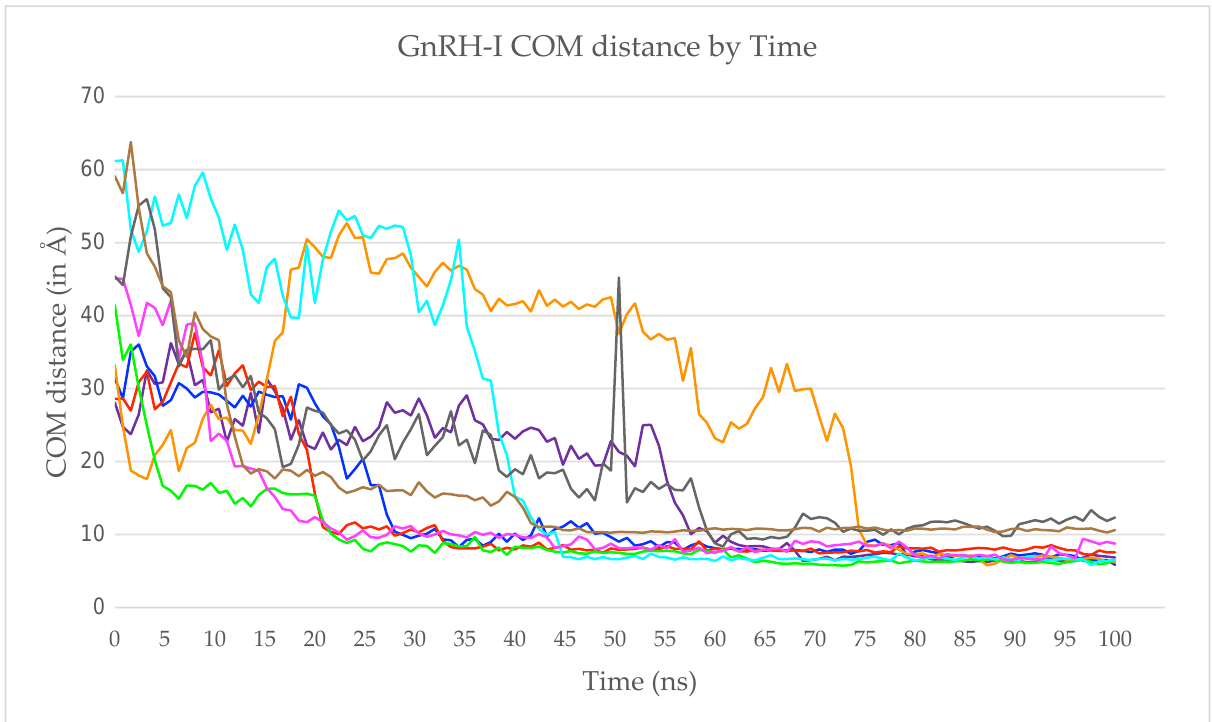
Figure 3. The GnRH-I centre-of-mass (COM) z-coordinates measured for a period of 100 ns following their release. The trace colours match those given in Table 1.